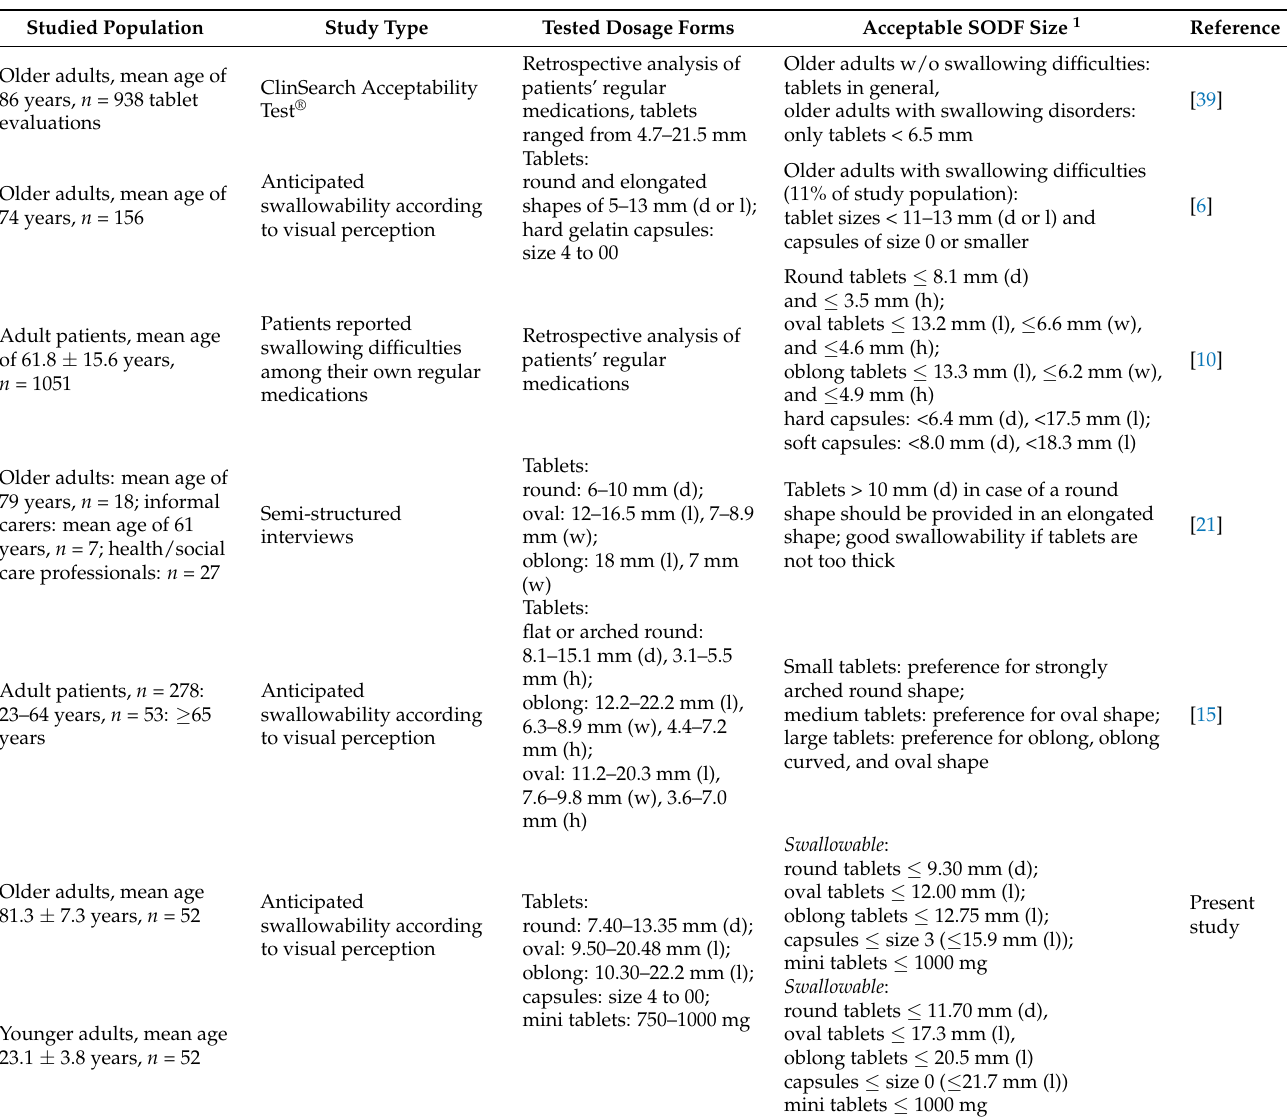
Table 6. Studies assessing dosage form swallowability according to visual perception or retrospective experiences of the participants with their own